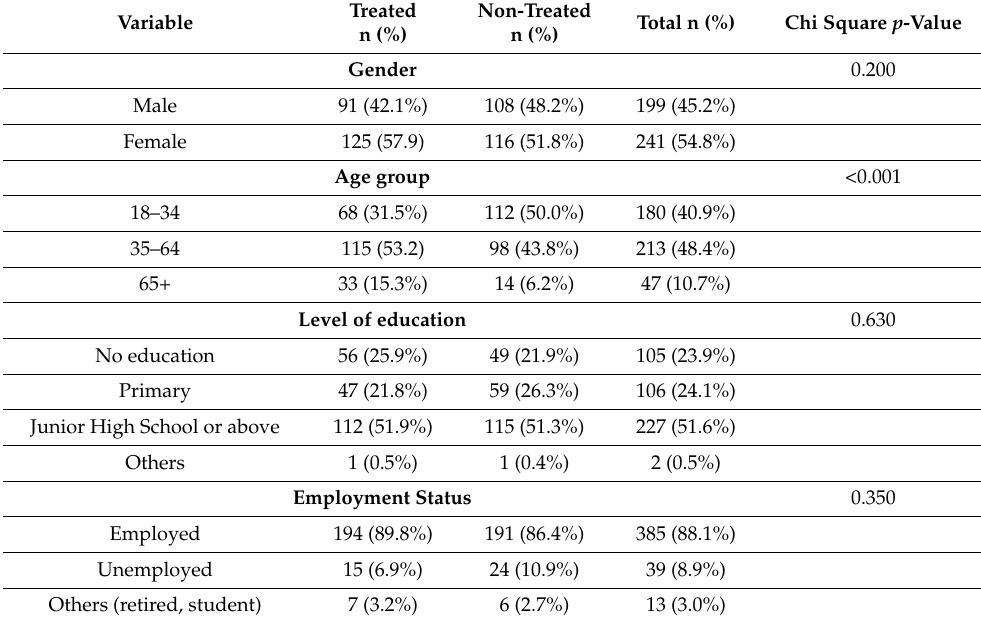
Table 1. Socio-demographic characteristics of survey participants.